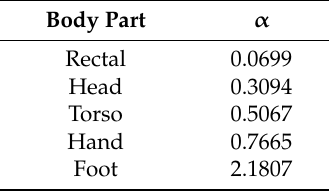
Table 1. Tuning parameters for the core temperature in each body